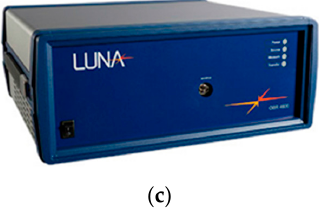
Figure 3. Photos of the experiment. ( a ) Test tank; ( b ) Loading device; ( c ) OBR 4600.